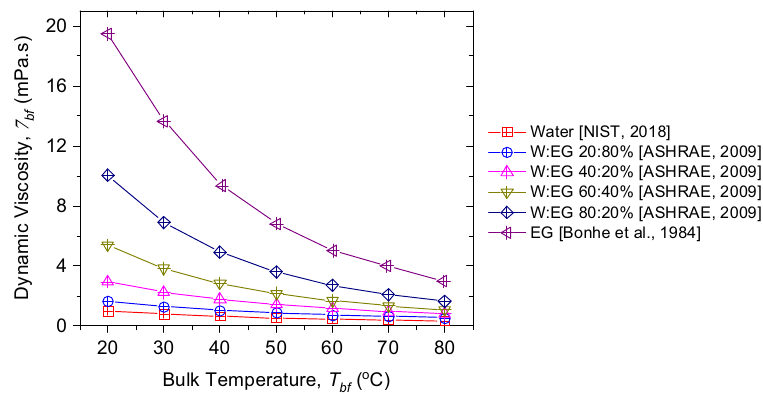
Figure 7: Dynamic viscosity of various types of base fl